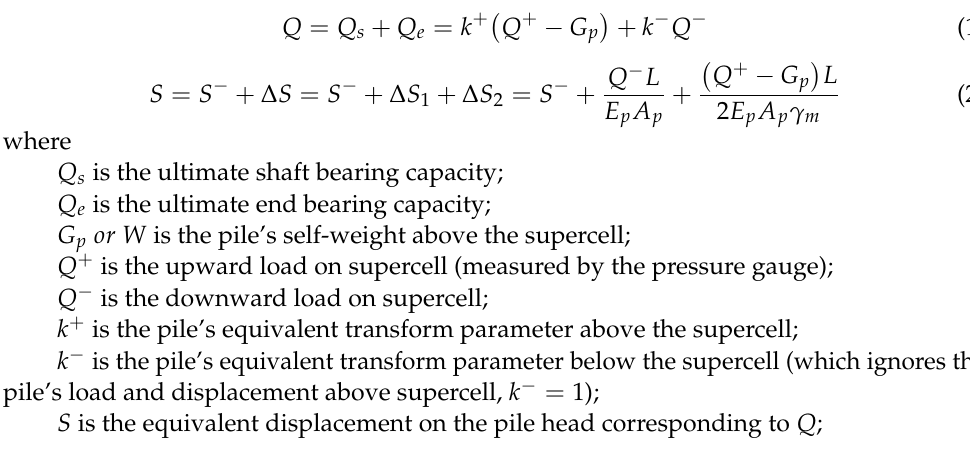
Figure 8. Q-s curve interpreted with equivalent method.